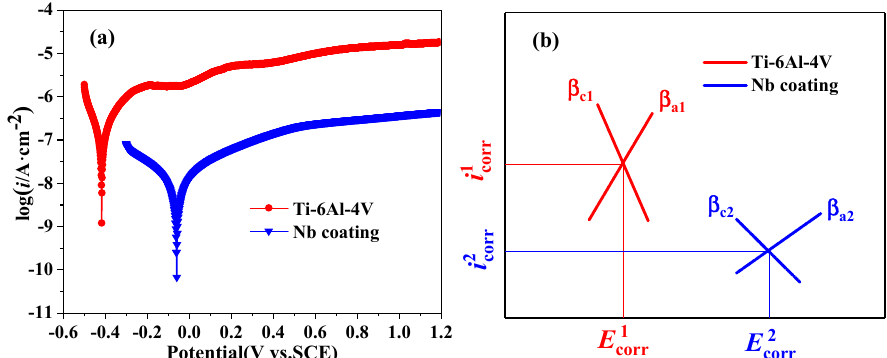
Figure 5. ( a ) Typical potentiodynamic polarization curves of the niobium coating and the substrate in Ringer’s solution at 37 °C. ( b ) Schematical explanation for the changes in E corr and i corr applying the mixed potential theory. Curve β a and curve β c is for the anodic and cathodic semireaction, respectively. Table 2. Electrochemical parameters collected from the polarization curves of the test samples in Ringer’s solution at 37 °C.